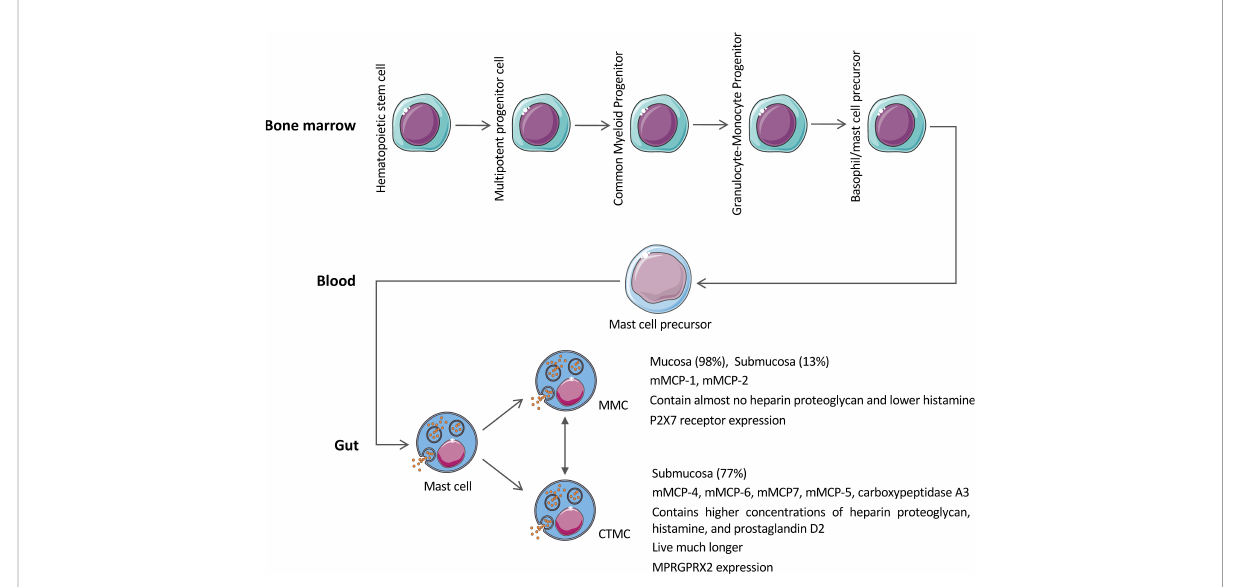
FIGURE 2 Heterogeneity of MCs. MCs mature uniquely, developing them more susceptible to the tissue homeostasis of the peripheral tissue microenvironment, and thus exhibit different subtypes and secrete different mediators to achieve different